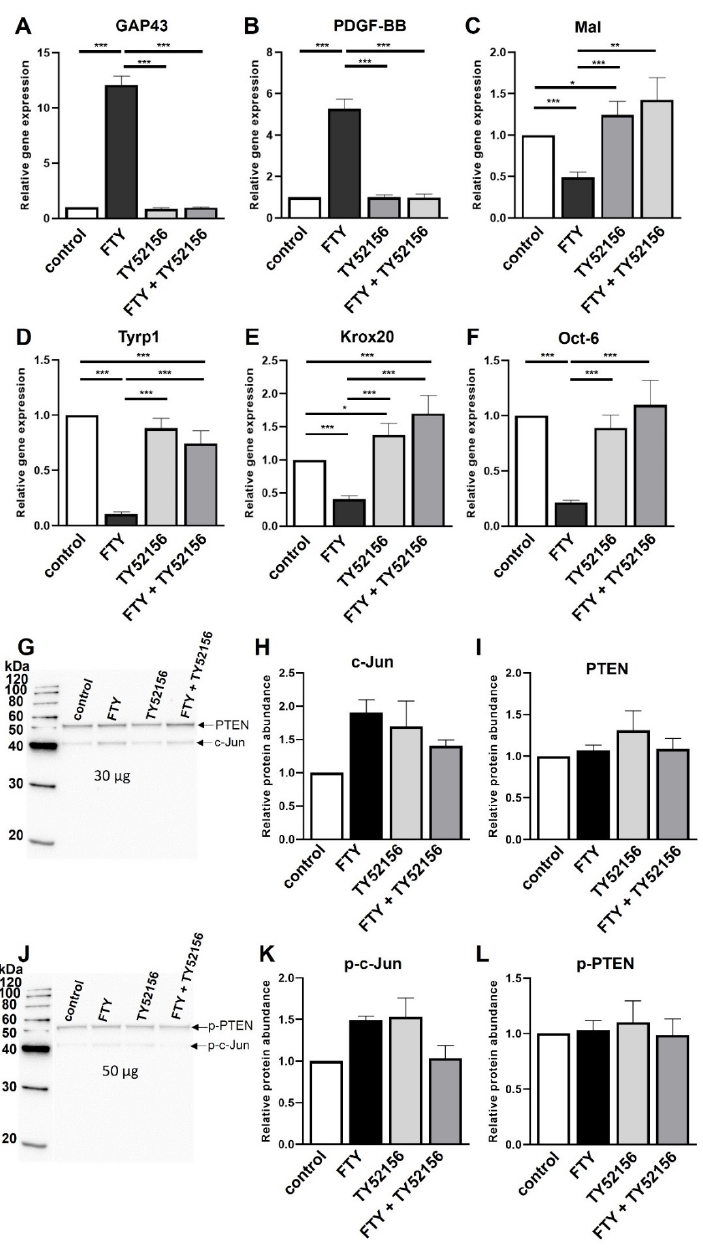
Figure 4. Induction of the repair Schwann cell phenotype by Fingolimod is neutralized by antagonizing S1P3. Co-application of Fingolimod (FTY) with TY52156 led to a reversed expression of GAP43 ( A ), PDGF-BB ( B ), Mal ( C ), Tyrp1 ( D ), Krox20 ( E ) and Oct-6 ( F ) compared to Fingolimod treatment alone having similar expression levels as control treated SCs. Treatment of SCs with the S1P3 antagonist alone led to a slight increase of Mal ( C ) and Krox20 ( E ). For statistical analysis, a